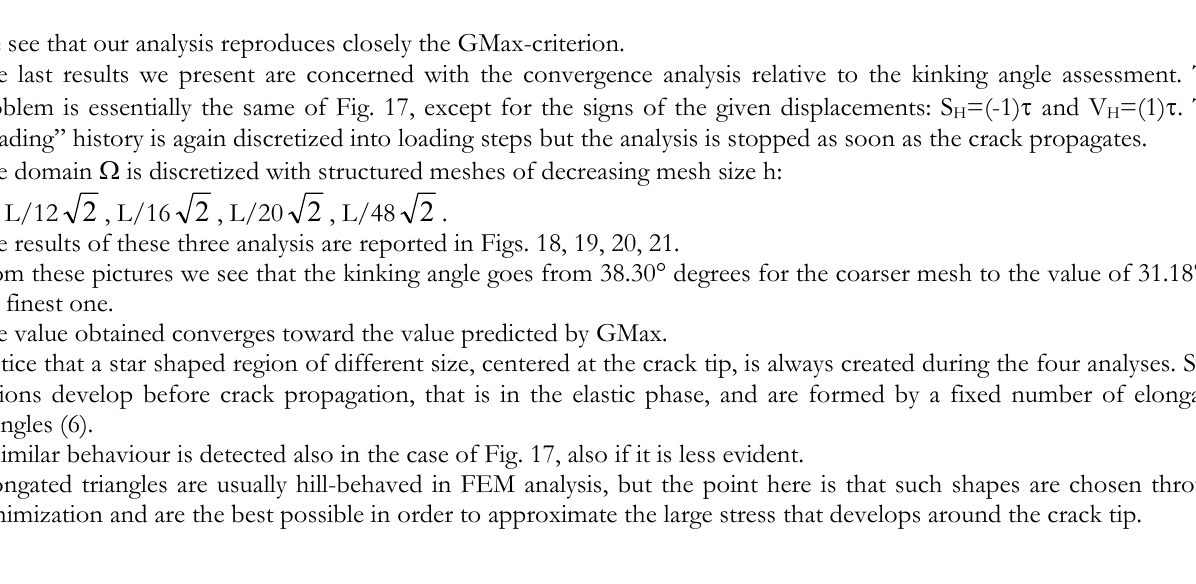
Table 2: Kinking angle with MTS, GMax criteria and from FEM